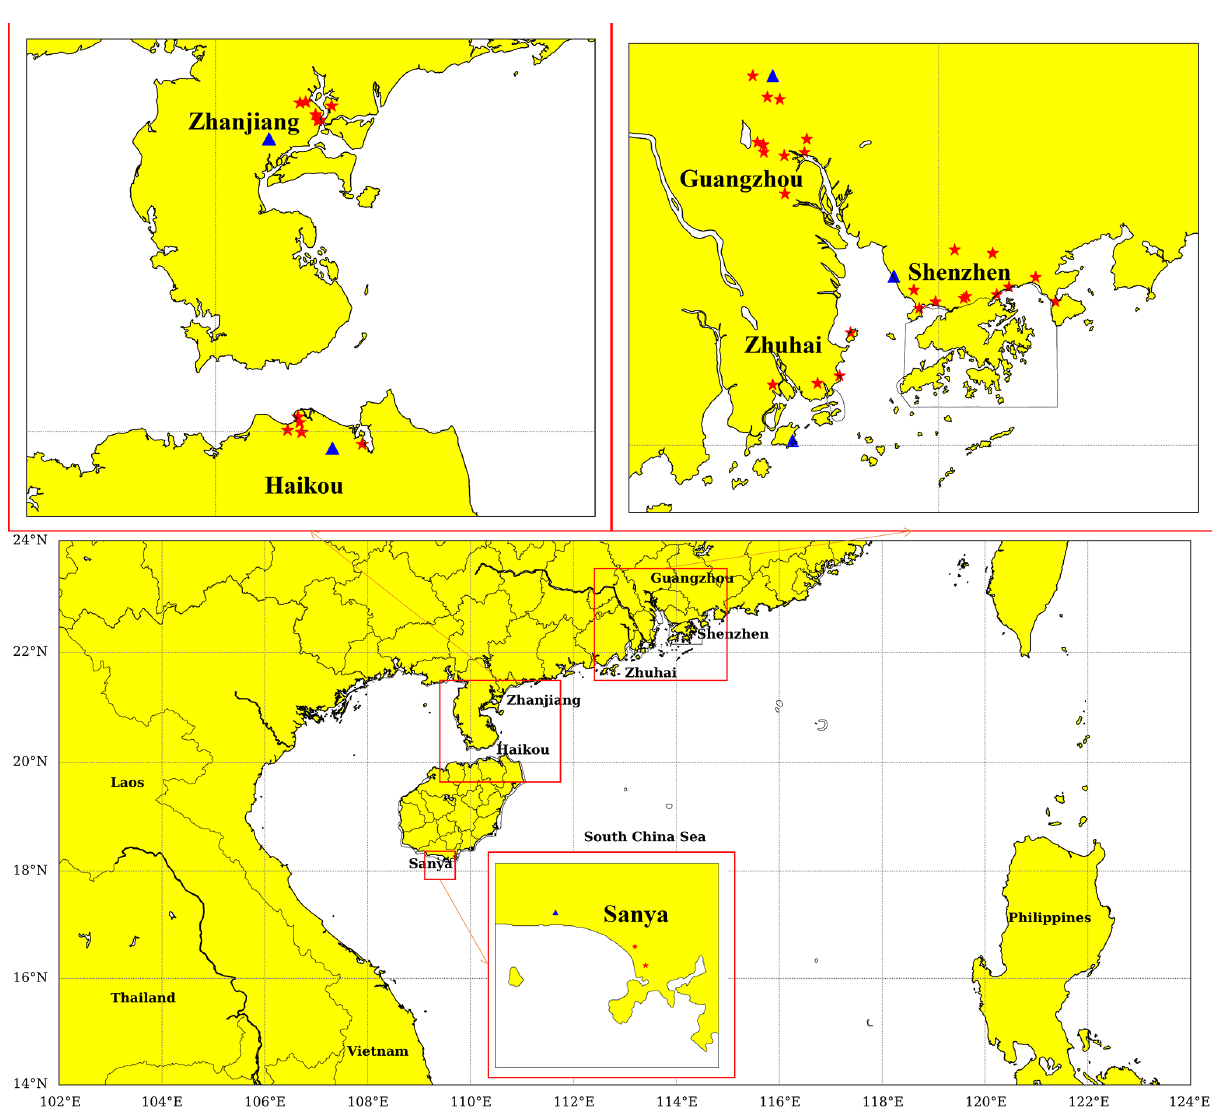
Figure 1. Maps of the study areas and locations of air quality monitoring stations (red star) and one meteorological station (blue triangle) in each